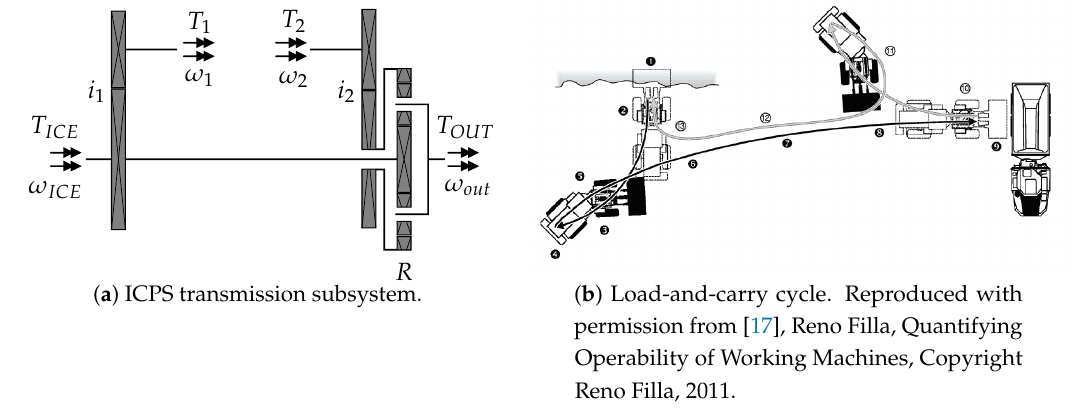
Figure 4. Reference vehicle transmission and drive